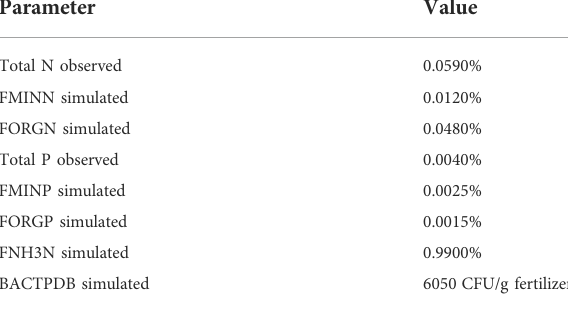
TABLE 3 Dairy ef fl uent fertilizer input data for